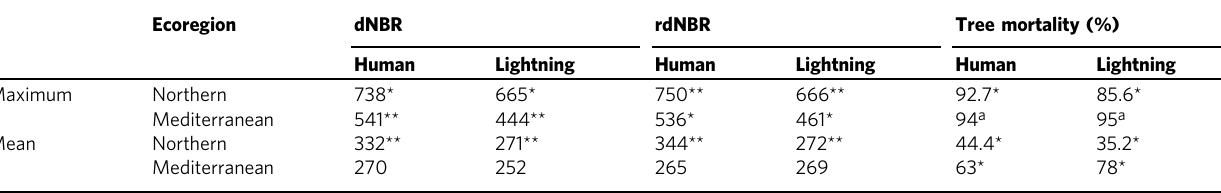
Table 2 Differences in fi re severity between human-caused and lightning-caused fi res.